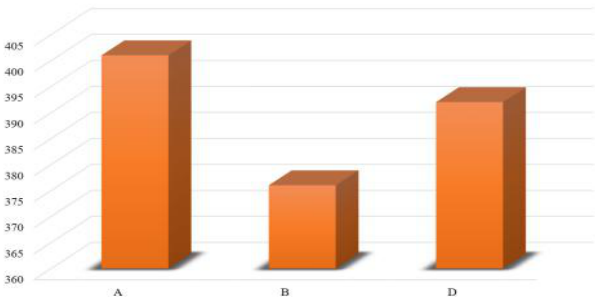
Figure 8. Distribution of unigenes containing SSR in the three subgenomes of hexaploid